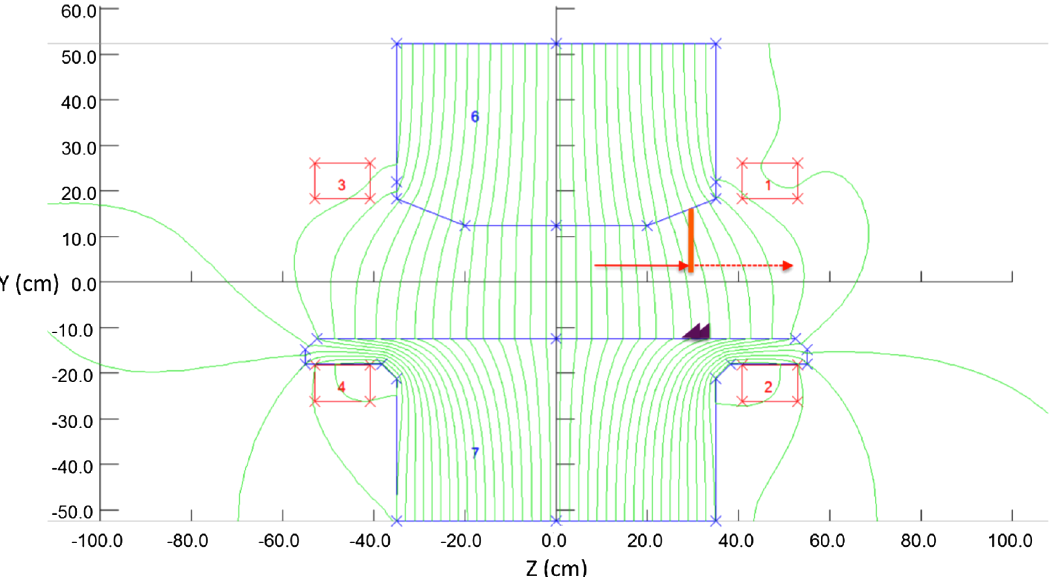
FIG. 1. The injection magnet with field lines generated by the OPERA code. Cartoon representations of the injection foil (orange line), the electron catcher (purple triangles), the incoming H (cid:1) beam (solid red arrow), and the outgoing proton beam (dashed red arrow) are drawn in approximately the correct locations, but are not to